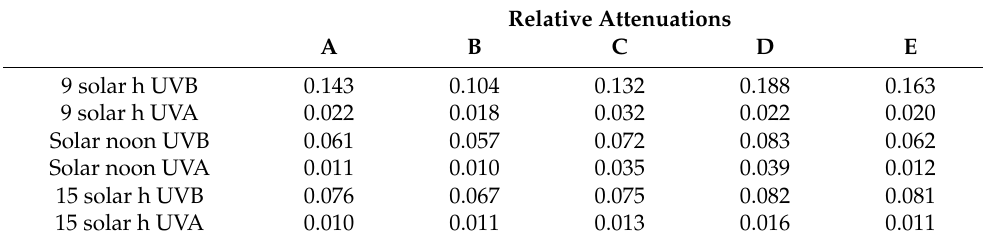
Table 4. Values of the mean relative attenuations for the UVB and UVA bands in winter at three times of